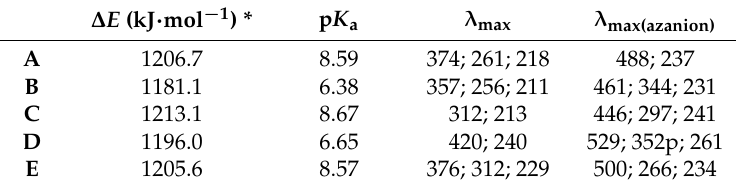
Table 6. Calculated values of deprotonation energies for isatin derivatives A – E , absorption maxima values from calculated UV–Vis spectra, and experimentally determined p K a values.